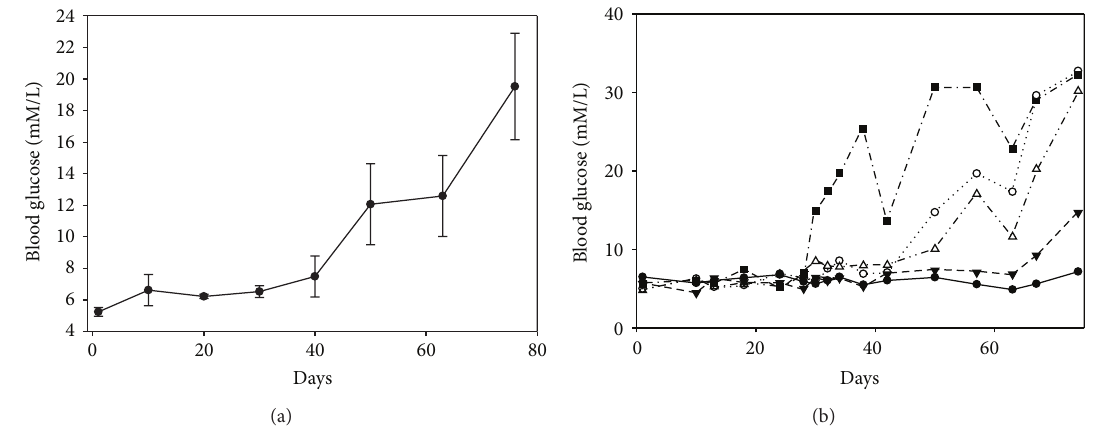
Figure 4: Blood glucose of NOD mice. (a) Average blood glucose levels gradually increased over an 80-day window in NOD mice. (b) In analyzing the progression of diabetes in the individual animals, there was wide variation in the onset of hyperglycemia, including some animals that did not develop hyperglycemia. Each line follows the blood glucose level for an individual mouse chosen to demonstrate the variation in diabetes